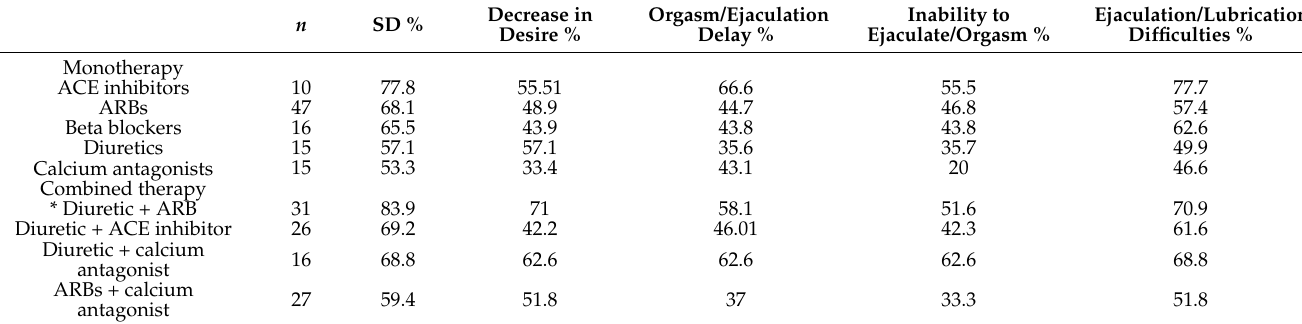
Table 3. Antihypertensives and frequency of sexual